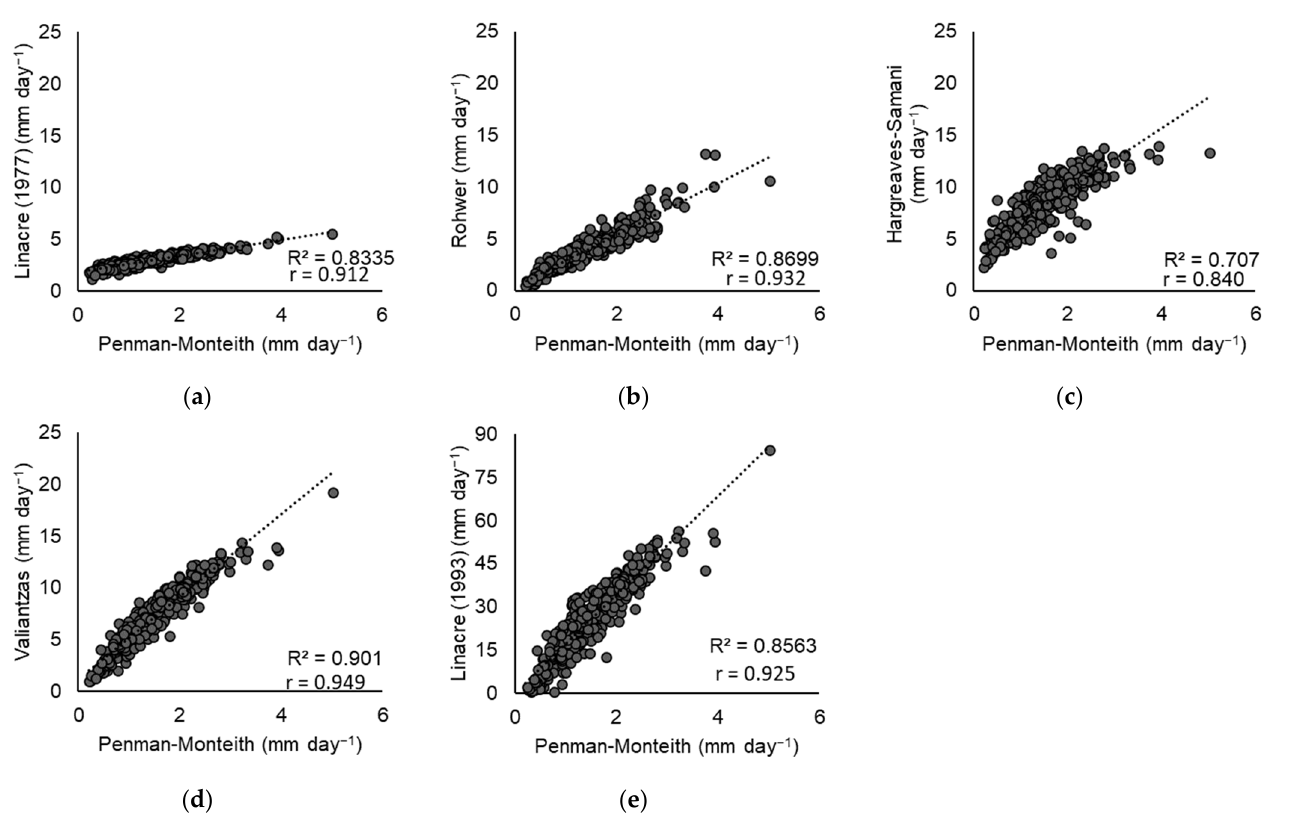
Figure 4. Linear regression between FAO Penman–Monteith and other methods. ( a ) Comparison of PM with Linacre (1977); ( b ) Comparison of PM with Rohwer; ( c ) Comparison of PM with Hargreaves–Samani; ( d ) Comparison of PM with Valiantzas; ( e ) Comparison of PM with Linacre (1993).